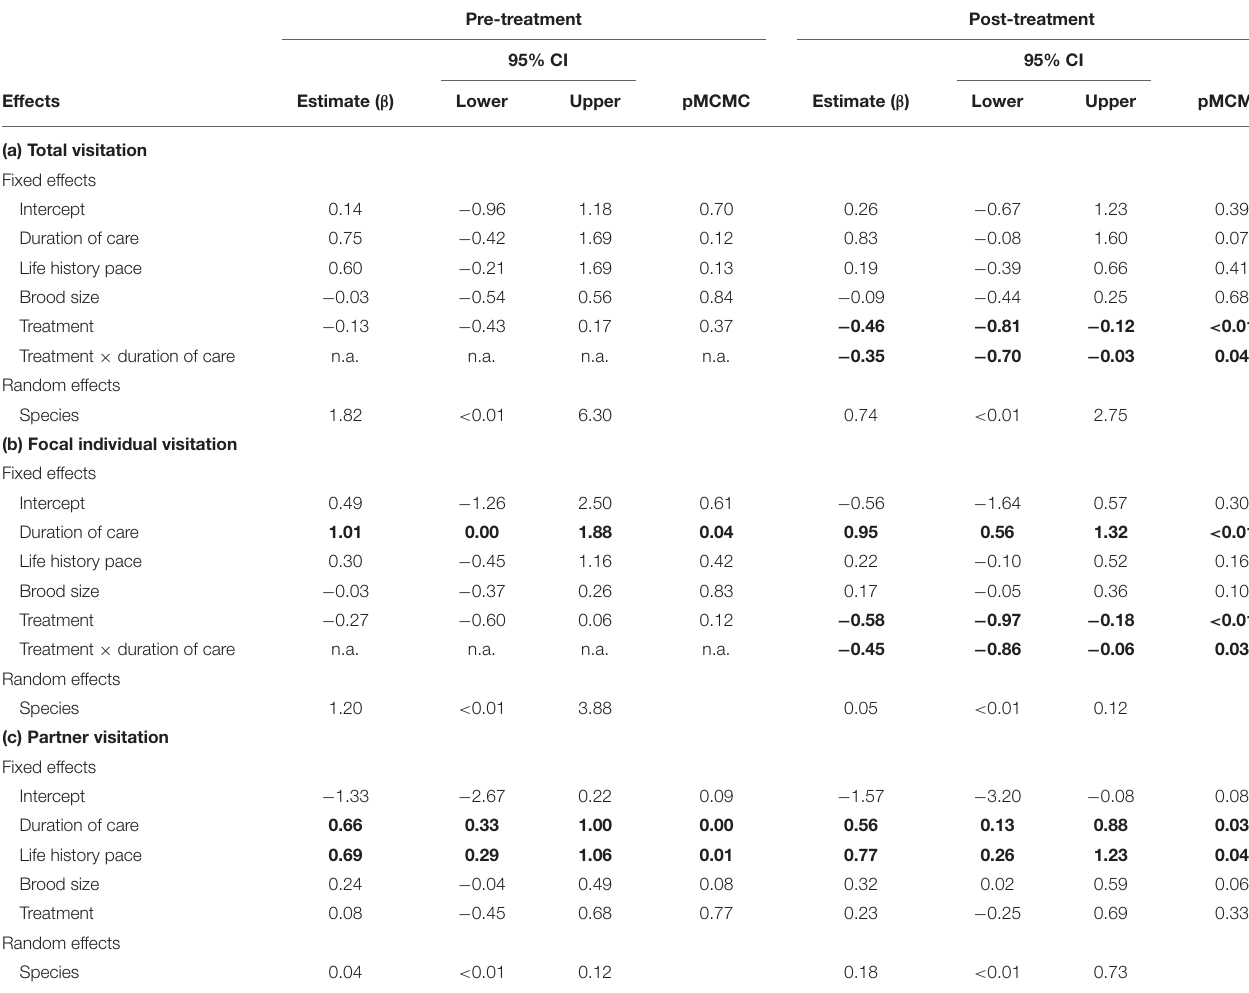
Table 3c ), and no included variable accounted for variation in partner